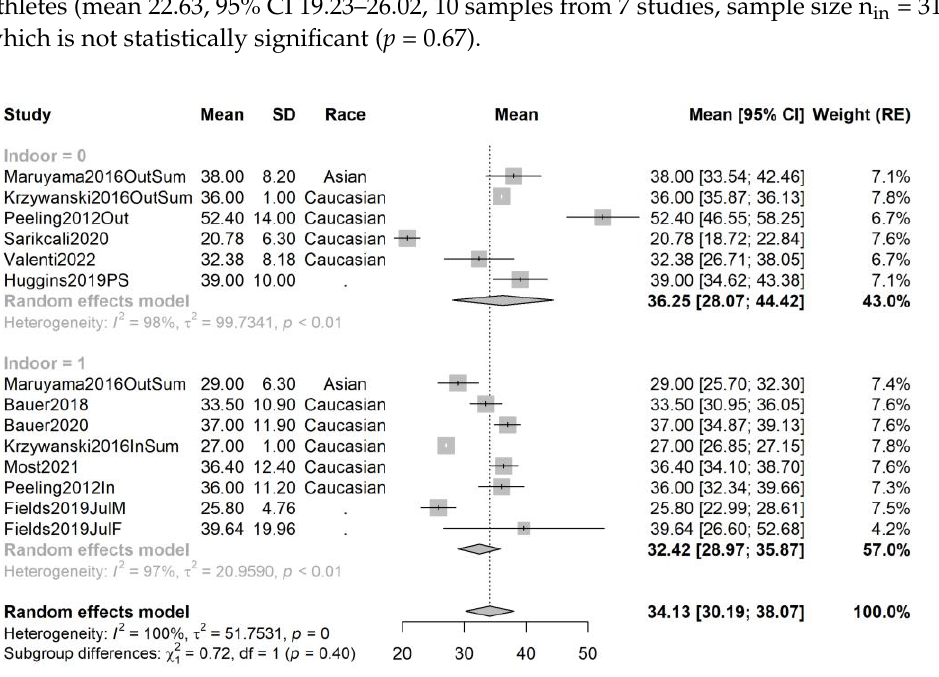
Figure 7. Forest plot of all studies performed in summer sorted by athletes’ race. Studies [54,57,65– 67,72].